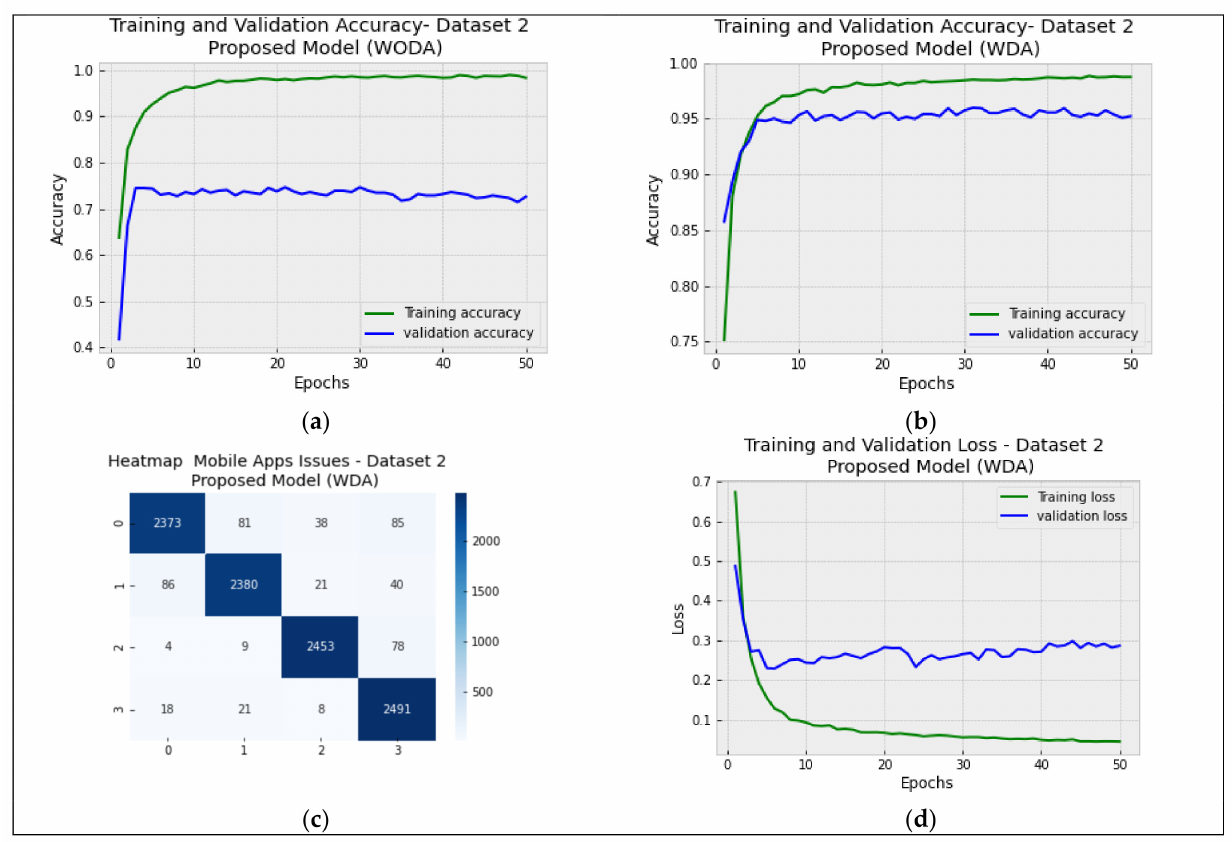
Figure 17. Proposed model validation and testing accuracy and loss using dataset 2: ( a ) model accuracy using dataset 2—WODA; ( b ) model accuracy using dataset 2—WDA; ( c ) confusion matrix (WDA); ( d ) training and validation loss. Table 11. Comparison between model performance for MLCs, DLs, and the proposed model. Approaches Dataset